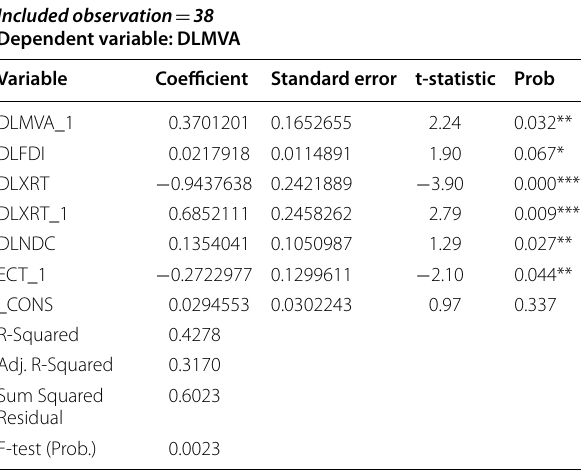
Table 9 Multicollinearity test results